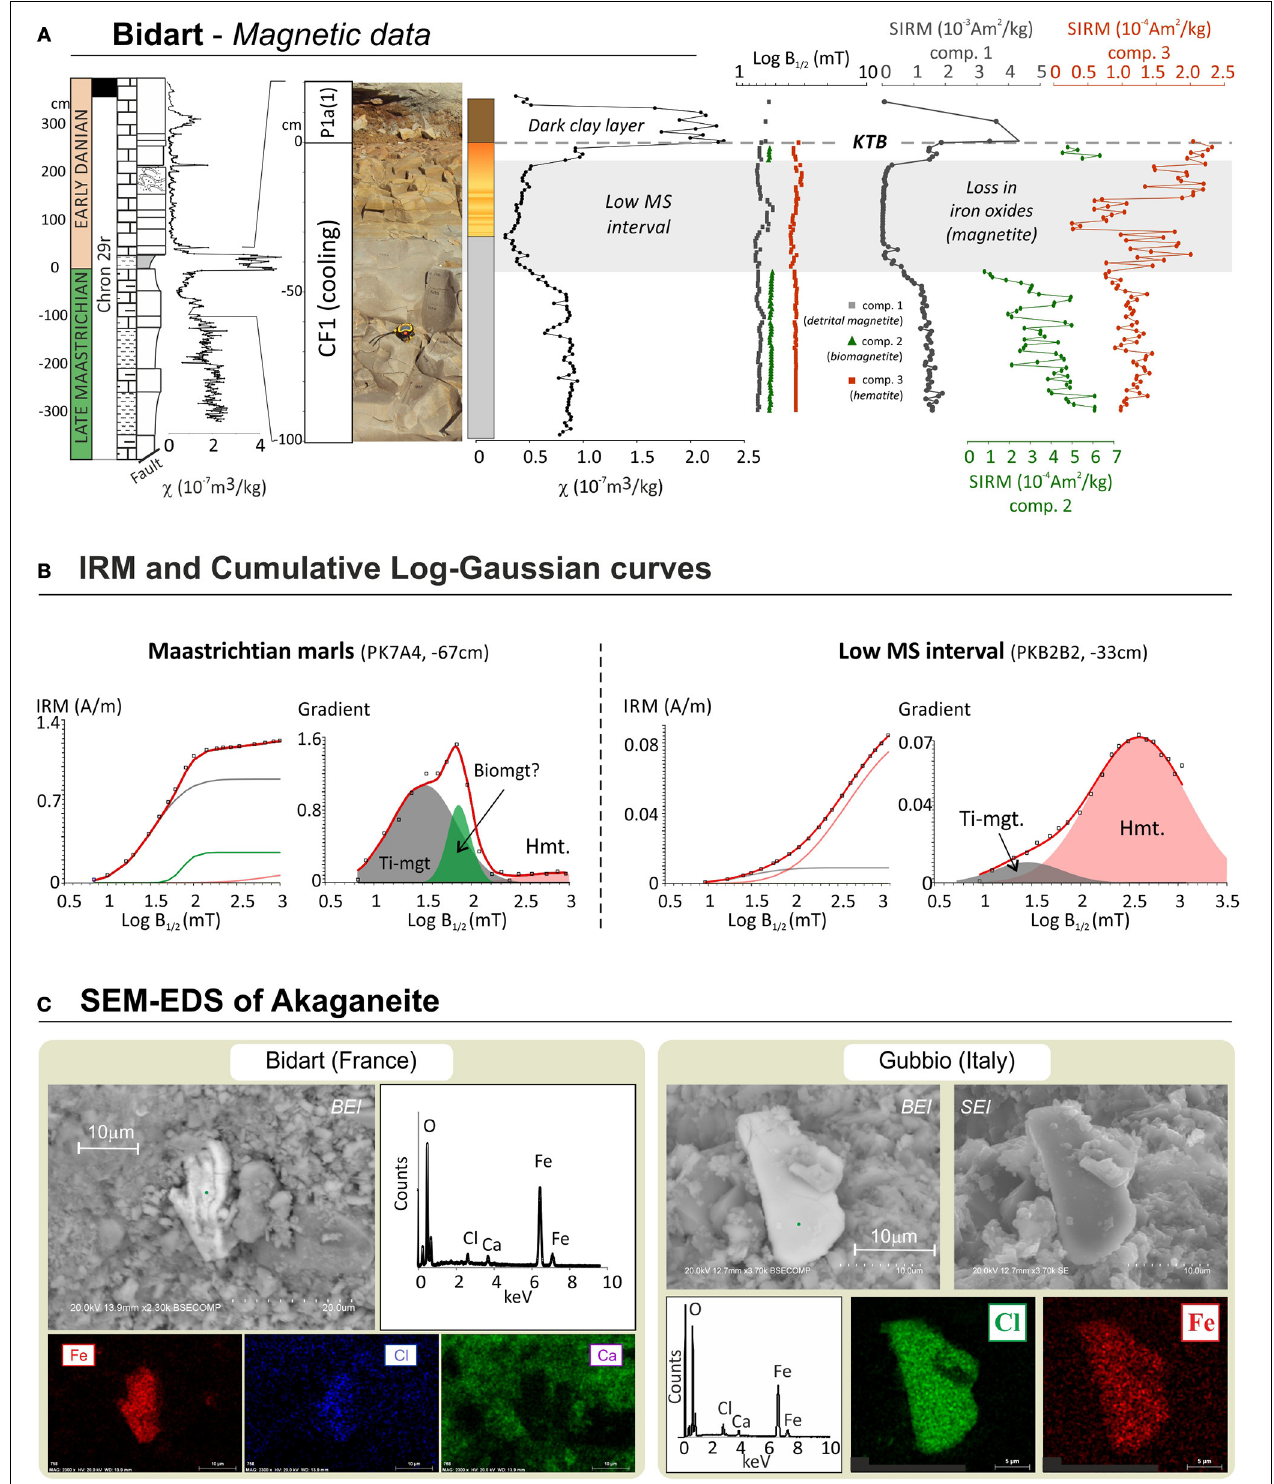
FIGURE 1 | (A) Magnetic data (mass magnetic susceptibility ( x ) and Isothermal Remanent Magnetization parameters) of the Bidart section [modified from Font et al. (2011, 2014)]. KTB is the Cretaceous-Tertiary boundary. Log B 1 / 2 (mT) is the mean coercivity of each magnetic component. SIRM corresponds to IRM values at saturation. Component 1